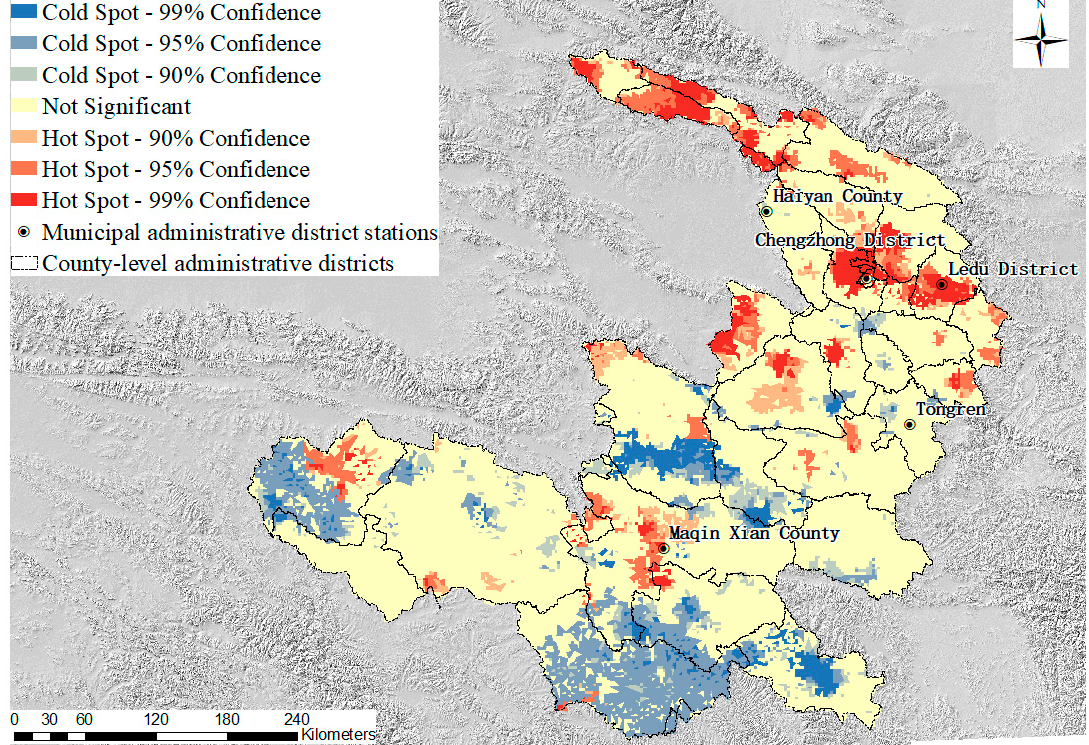
Figure 8. Distribution map of ecological risk hotspot areas of mining in the source area of the Yellow River Basin.